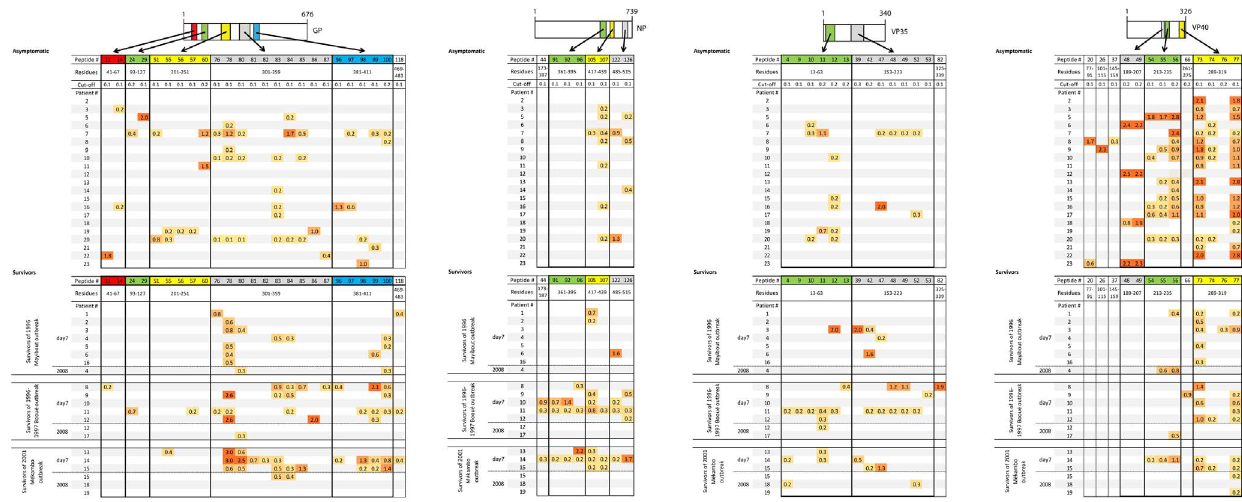
Figure 2. Mean OD values at 1:400 serum dilution in patients infected with EBOV during three outbreaks in Gabon, 7 days after symptom onset (Day 7, early humoral response) and 7 or 11 years later (2008, late humoral response), and also in anti-EBOV IgG + asymptomatic individuals who had never had clinical signs of hemorrhagic fever or who lived in non epidemic areas*. ODs are color- coded to indicate their intensity (yellow to red). The different colored regions in the proteins indicate the immunodominant domains identified here. *Blank cells indicate that the mean OD was lower than the cut-off. OD: Optical Density. The absorbance cut-off used to identify reactive epitopes is described in the Methodology section.